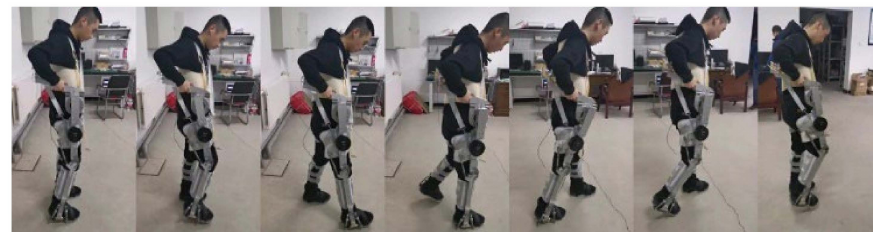
Figure 33. Walking gait experiment of lower-limb exoskeleton rehabilitation robot.